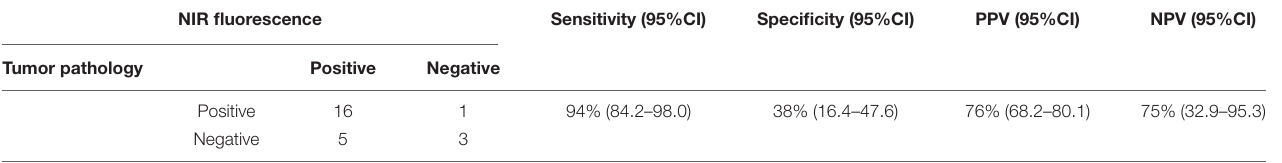
TABLE 3 | Dura mater samples from the dural tail on pre-operative MRI in 25 samples from 12